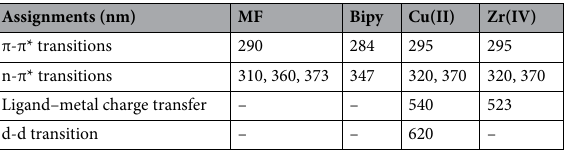
Table 2. The given UV–Vis. electronic transitions of MF, Bipy and their metal complexes.